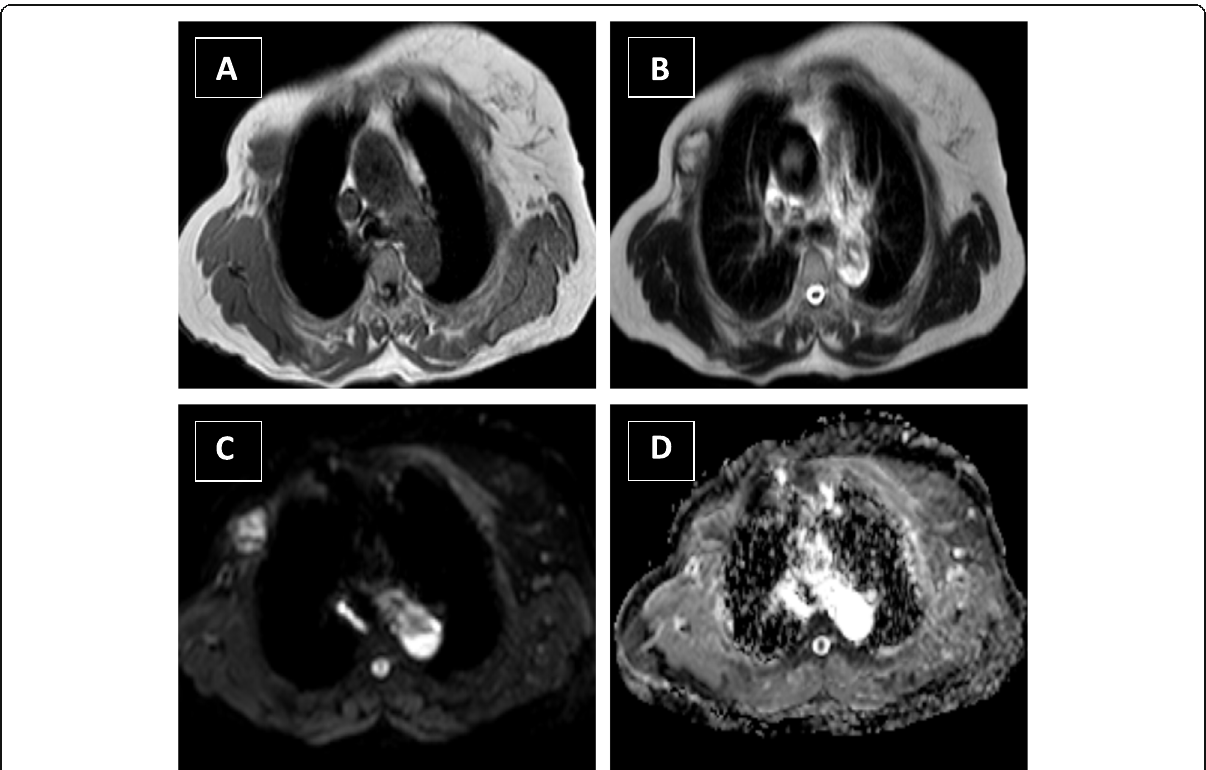
Fig. 5 A 72-year-old female patient presented with postoperative right mastectomy bed swelling. MRI chest wall shows a rather well-defined soft tissue mass at the operative bed with no intra-thoracic extension, eliciting isointense signal intensity in T1WI ( a ) and intermediate to high signal intensity in T2 WI ( b ) with intermediate to high signal in diffusion WI ( c ) and intermediate to low signal in ADC map ( d ). The ADC value was 1.3 ± 0.03 × 10 − 3 mm 2 /s, and the mass was pathologically proven to be a non-neoplastic lesion (cicatricial